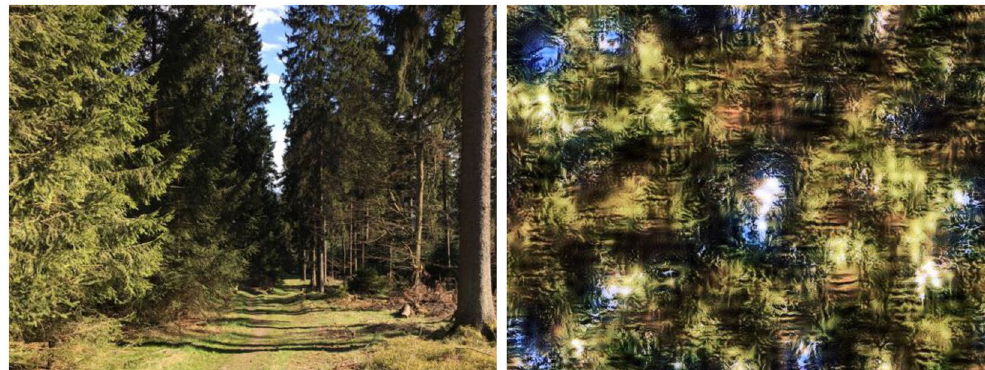
Figure 1. Example of a texture (right) that preserves similar summary statistics as compared to a forest scene (left) but discards global shape